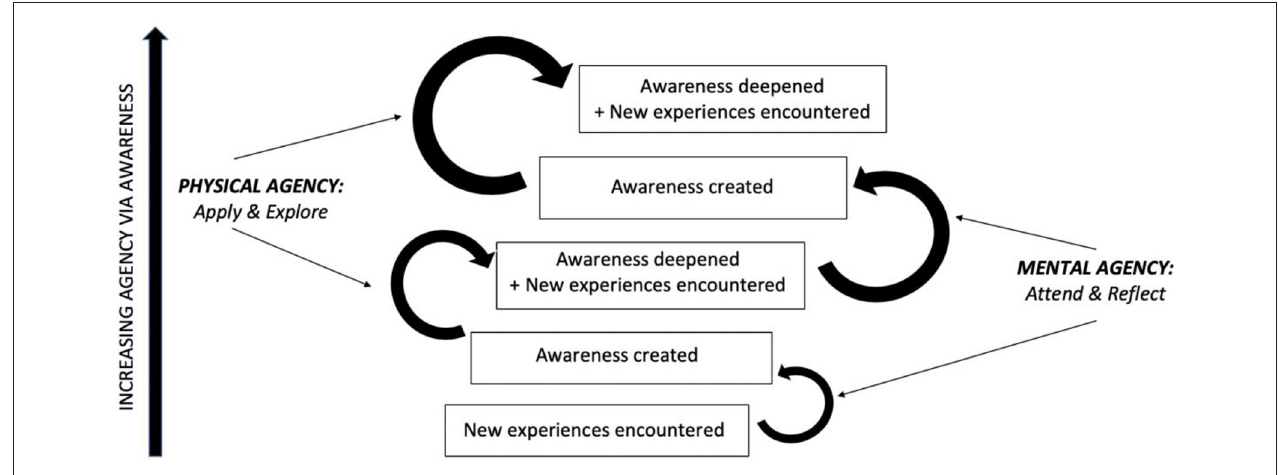
FIGURE 1 | Schematic illustration of agency via awareness meta-process aimed at in psychotherapy. The rounded arrows, starting from the bottom, represent the successful exercise of mental and physical agency, whereas the text boxes represent stages of increasing awareness. As demonstrated in the figure, new awareness is created via attention to and reflection (mental agency) on new (internal or external, encountered or created) experiences; this awareness is then applied (to internal and/or external experiences) and inspires further exploration, which leads to gradual deepening of awareness as well as further new (internal or external, encountered or created) experiences, thus providing further opportunities for creating or deepening awareness and thereby increasing agency. Of note, clients may get “stuck” at any of these stages, and the aim of therapy is to provide the experiences and/or facilitate the agential work that will allow clients to make forward progress through this